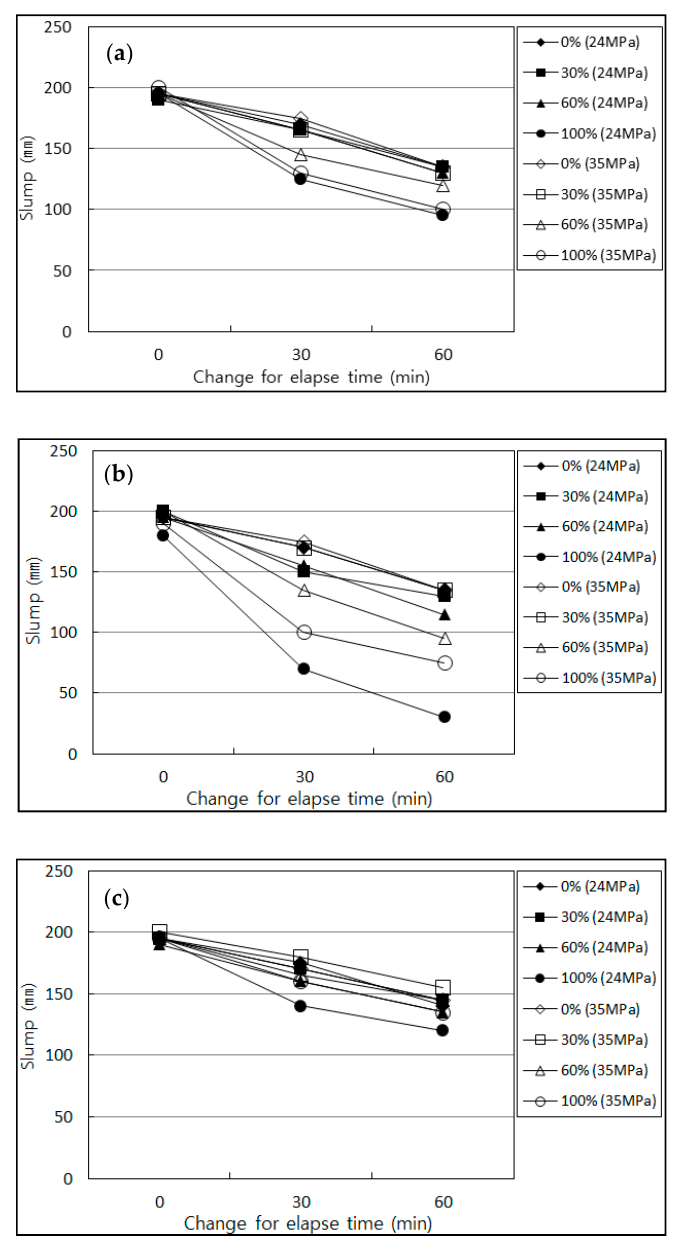
Figure 10. Slump change for strength area and replacement rate. ( a ) Recycled coarse aggregate replacement, ( b ) recycled fine aggregate before modification, and ( c ) recycled fine aggregate after modification.